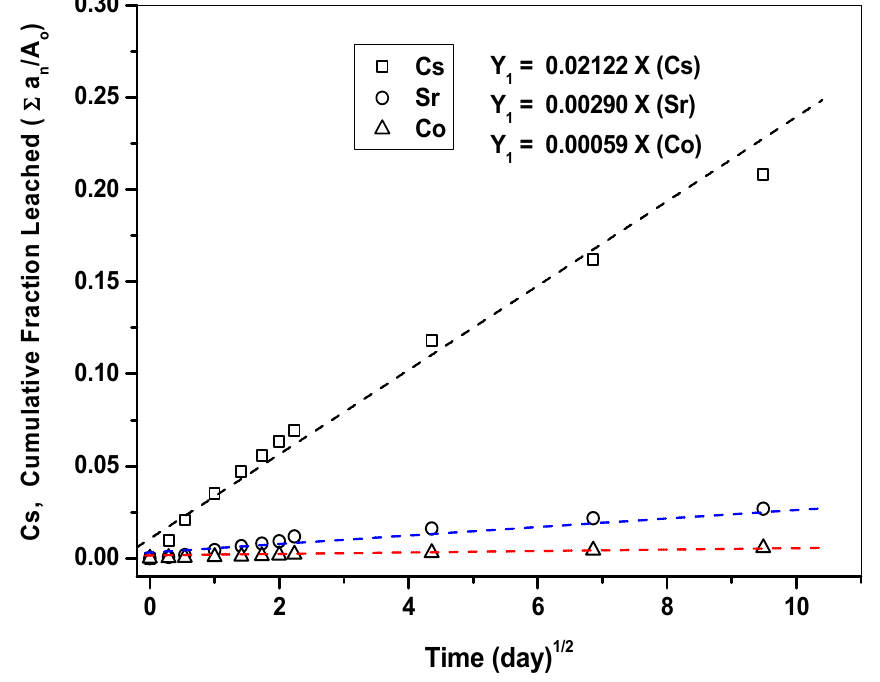
Figure 10. Respective CFLs for each nuclide (Cs, Sr, and Co), along with the slopes of each curve. Table 11. Effective diffusion coefficient and leaching indexes for each nuclide (Cs, Sr, and Co).